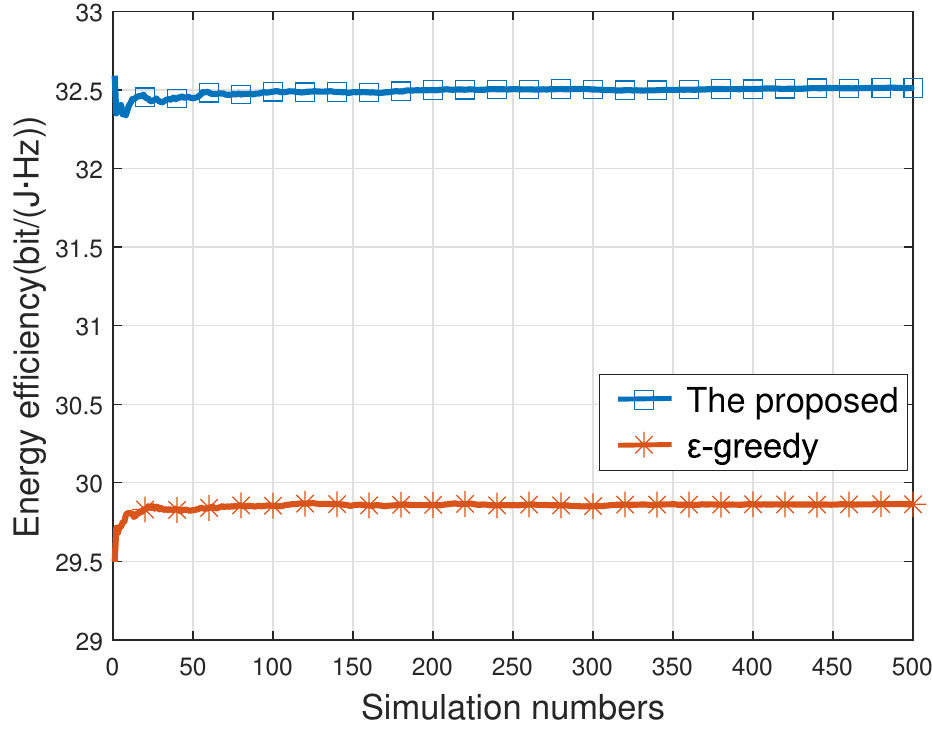
Figure 11. Energy efficiency simulation